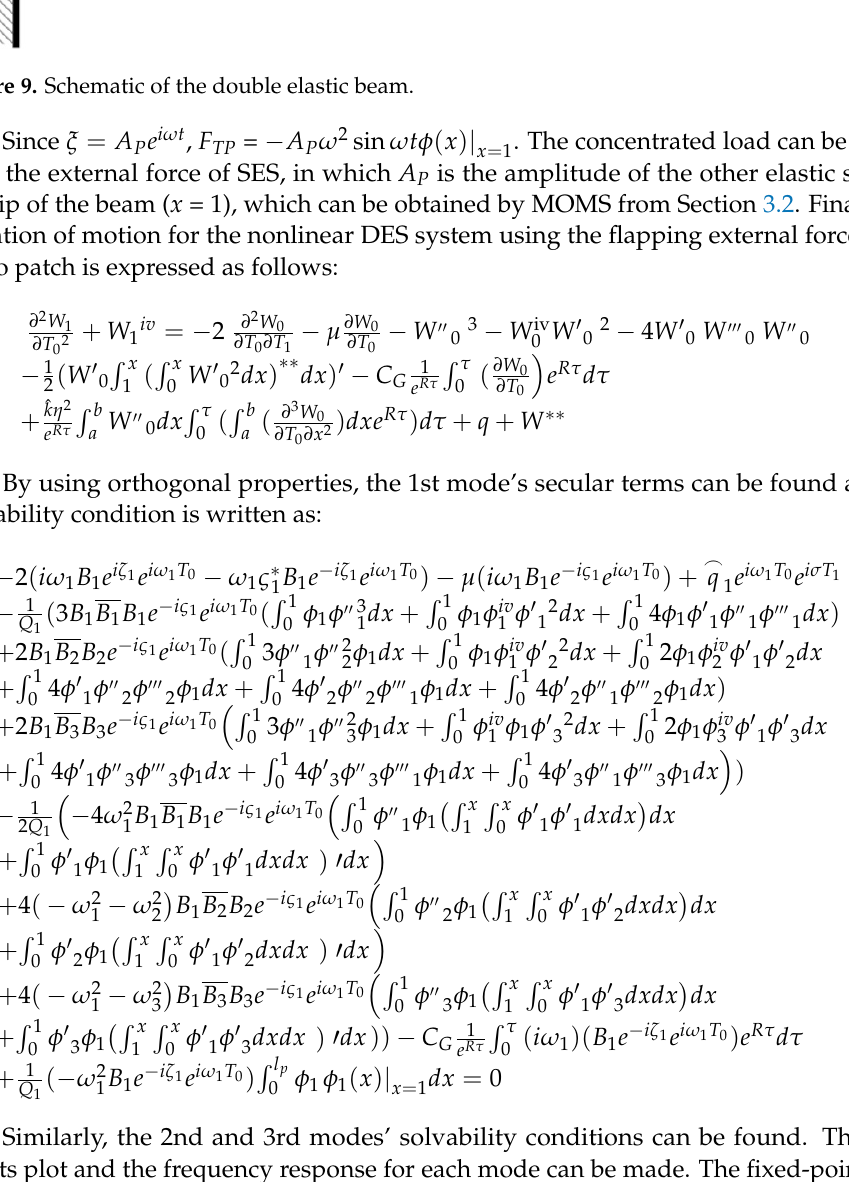
Figure 9. Schematic of the double elastic beam.